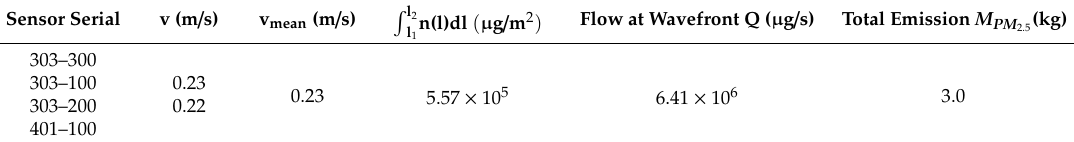
Table A3. PM 2.5 Emission calculation from ground level smoke-wave B.